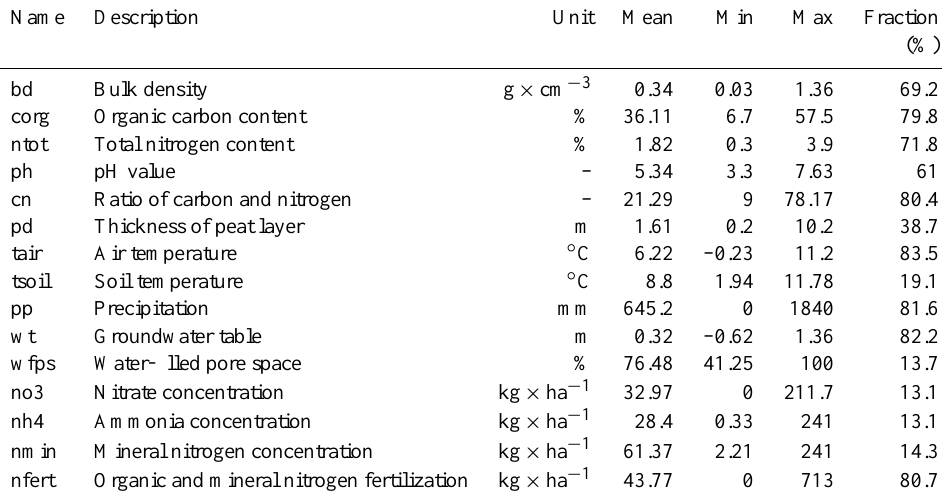
Table 1. List of potential driving parameters for N 2 O with units, value mean/range and fraction of measurement studies that cover each parameter. Soil parameters are related to topsoil layer of 100cm depth and all parameters are calculated as annual average values, with the exception of precipitation and nitrogen fertilization, which are calculated as annual